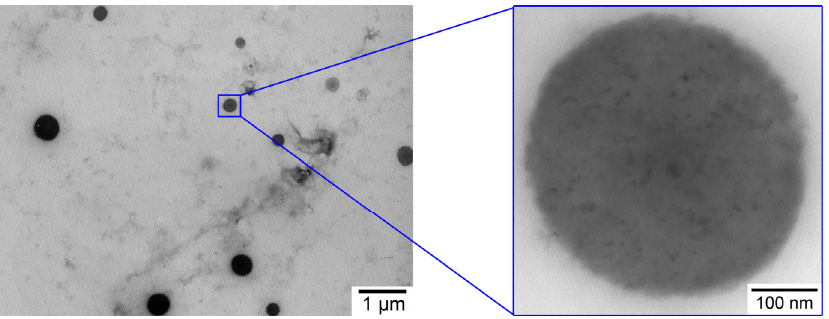
Figure 8. Electron microphotographs of polymer nanocomposite 3 . SEM images of the synthesized PVI and nanocomposite with CuNPs evidence their different surface morphologies (Figure 9). According to the data of scanning electron microscopy, the PVI has a highly developed fine-grained surface structure with granules 100–200 nm in size (Figure 9a). At the same time, the surface of nanocomposites has a denser structure with enlarged granules (Figure 9c). According to the EDS analysis, the elemental composition of different parts of the PVI surface is identical, which indicates the homogeneity of the polymer and nanocomposites (Figure 9b,d).